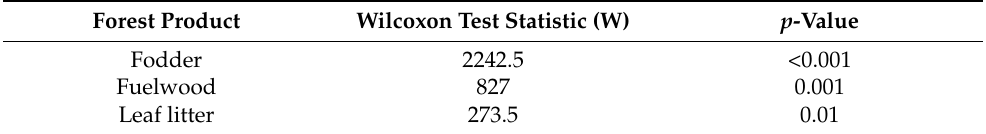
Table 4. Wilcoxon test result for Hypothesis 2